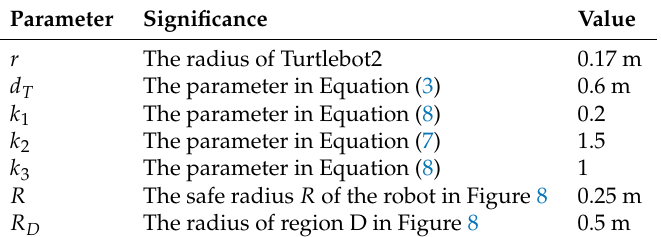
Table 1. The parameters in the